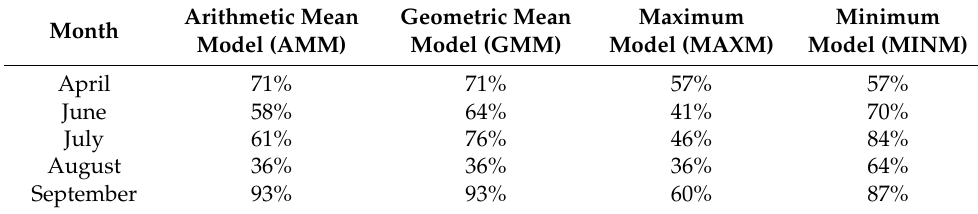
Table 3. Accuracy validation of HSI